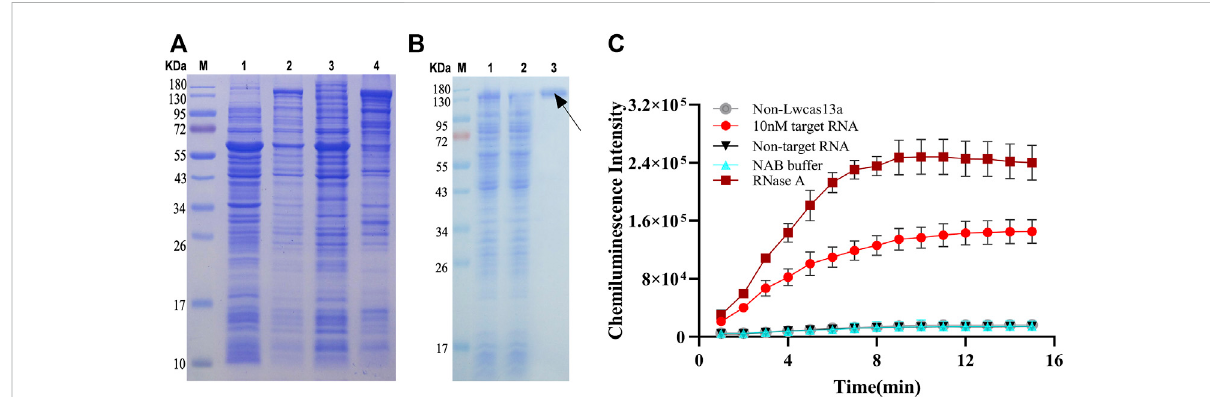
FIGURE 1 LwCas13a protein expression, puri fi cation and veri fi cation. (A) The expression of LwCas13a protein. M, marker; lane 1, E. coli wasn ’ t induced by IPTG,lane2,IPTGinducedE.coliovernight;lane3,precipitationofbrokencells;lane4,supernatantofbrokencells. (B) Thepuri fi cationofLwCas13a protein. M,marker; lane1,supernatantofbroken cells;lane2, fl ow-through treatedwith SUMO enzyme. Lane3, Eluent. (C) Veri fi cationofLwCas13a